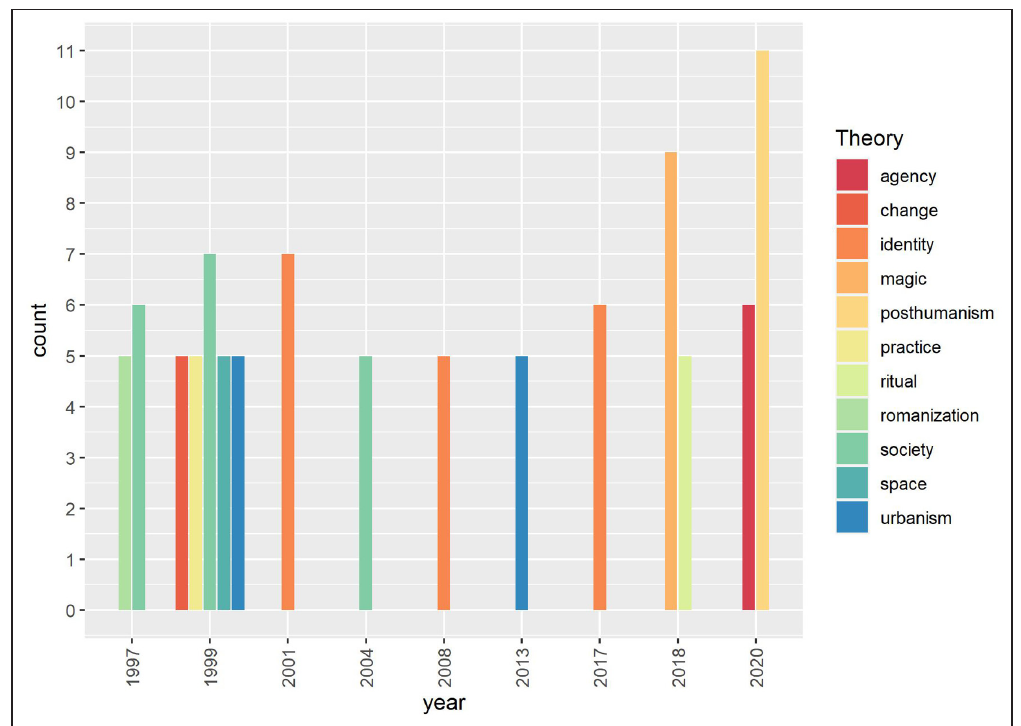
Figure 5: Frequency of ‘theory’ key words used in TRAC publications per year (all terms used more than five times per year are